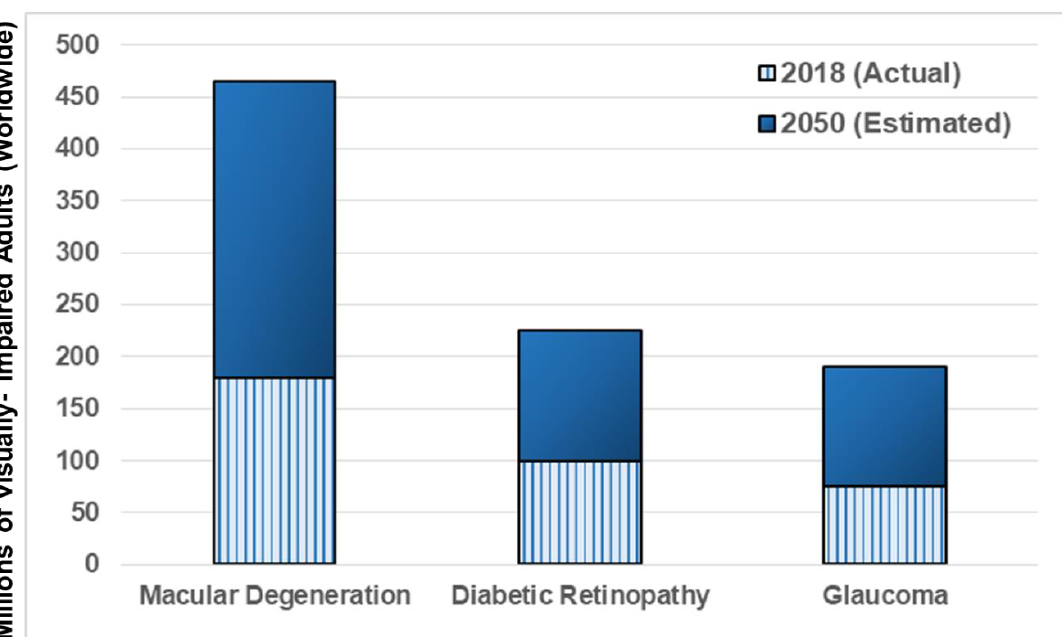
Figure 2. Numbers of adults diagnosed with the most prevalent retinal diseases, worldwide. Hashed bars reflect actual numbers of adults visually-impaired in 2018 with macular degeneration (wet and dry), diabetic retinopathy (proliferative and non-proliferative), and glaucoma (all subtypes). Solid bars denote estimated numbers of visually-impaired adults for each affected population by the year 2050, where the World Health Organization (WHO) expects to record dramatic increases (as per data from [80]).